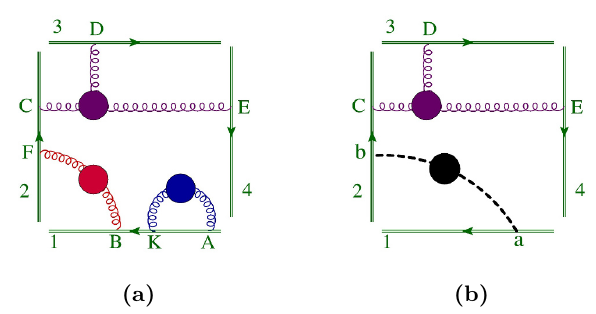
(1 , 1 , 2 , 3) and the corresponding Figure 25. Cweb W (2 , 1) 4 , II